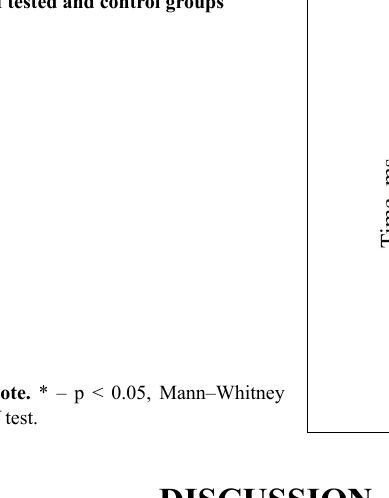
Figure 4. The complex reaction time of tested and control groups